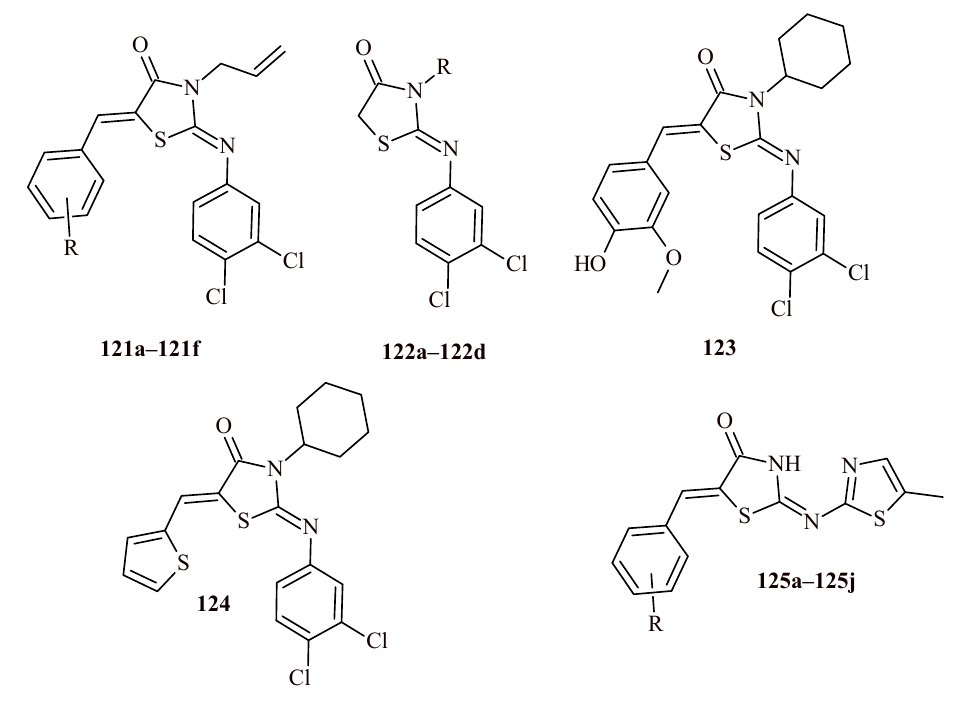
Figure 51. The structures of 2-iminothiazolidin-4-one derivatives.